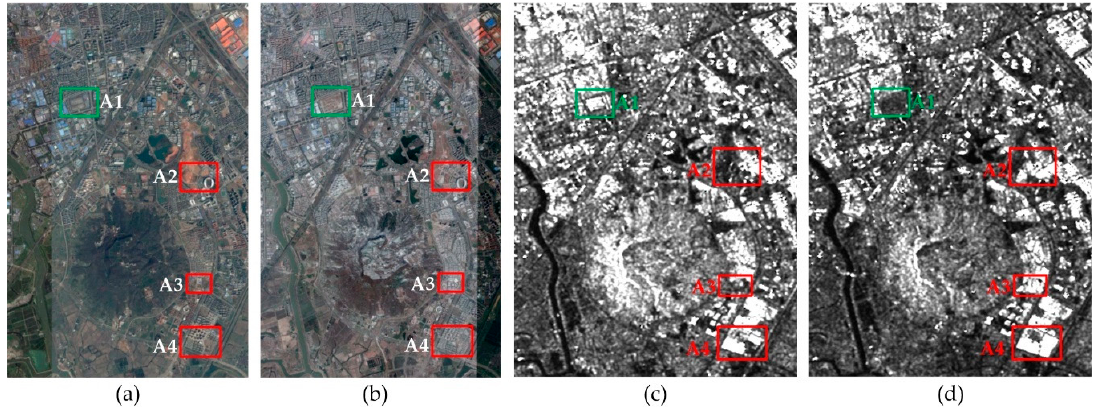
Figure 4. An example of positive and negative building changes using Google Earth optical and SAR images in Jiangning District.